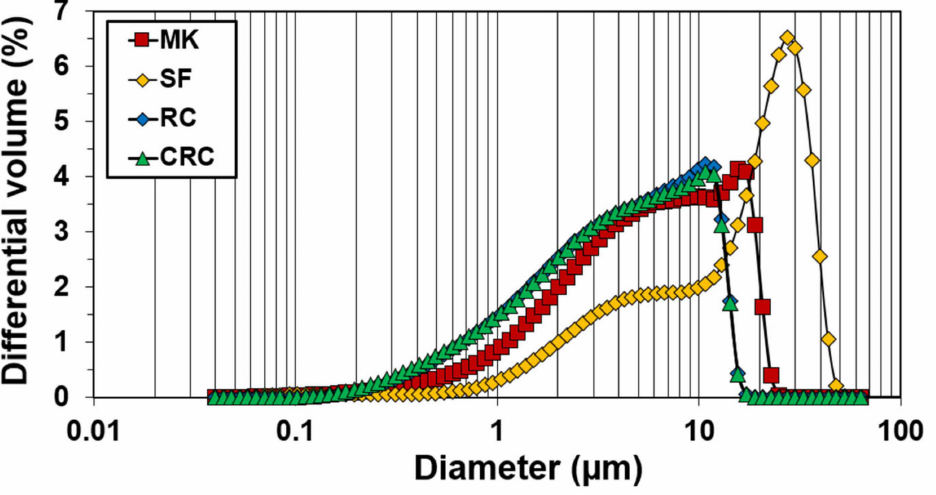
Figure 2. Particle size distribution of the precursors used to manufacture alkali activated binders and